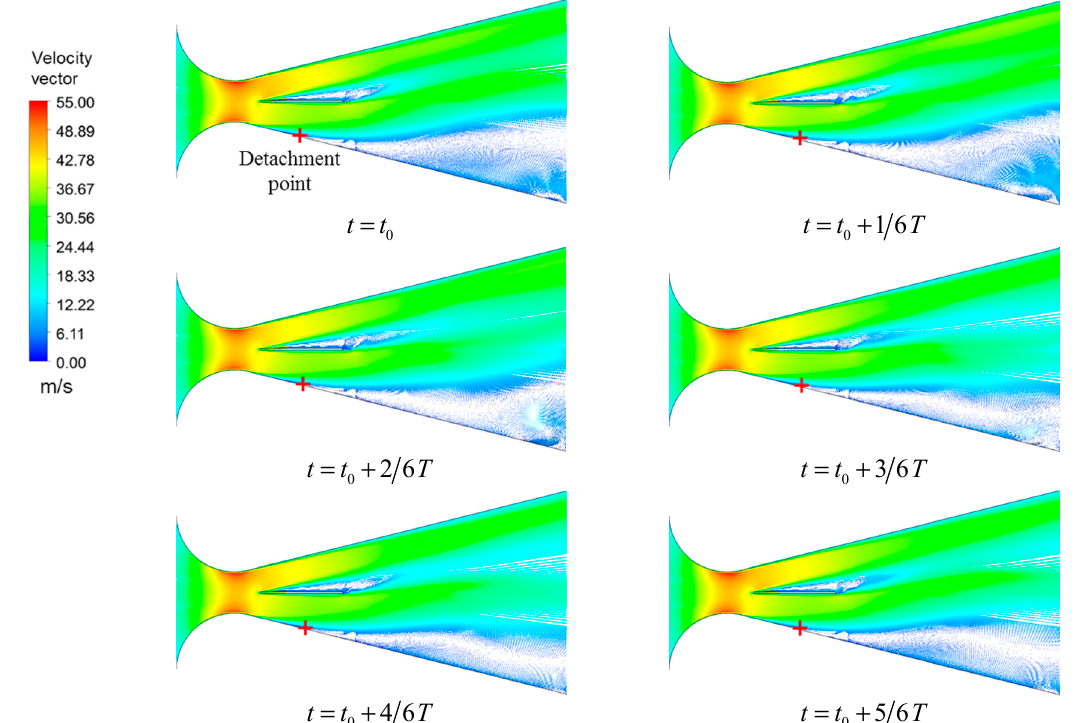
Figure 10. Snapshots of the velocity field in the vaned diffuser ( t 0 = 5 s).